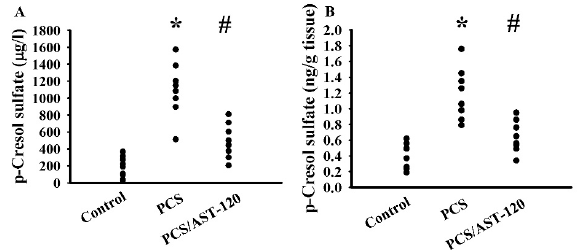
Figure 3. Peripheral PCS treatments increased its CNS distribution. Unilateral nephrectomized mice were intraperitoneally injected with PCS (0, Control; and 100 mg/kg, PCS) and the PCS-injected mice were orally given with AST-120 (400 mg/kg, PCS/AST-120) for 7 weeks. The blood ( A ) and prefrontal cortical tissues ( B ) were isolated and subjected to the measurement of PCS. * p < 0.05 vs. control group and # p < 0.05 vs. PCS group, n = 8.